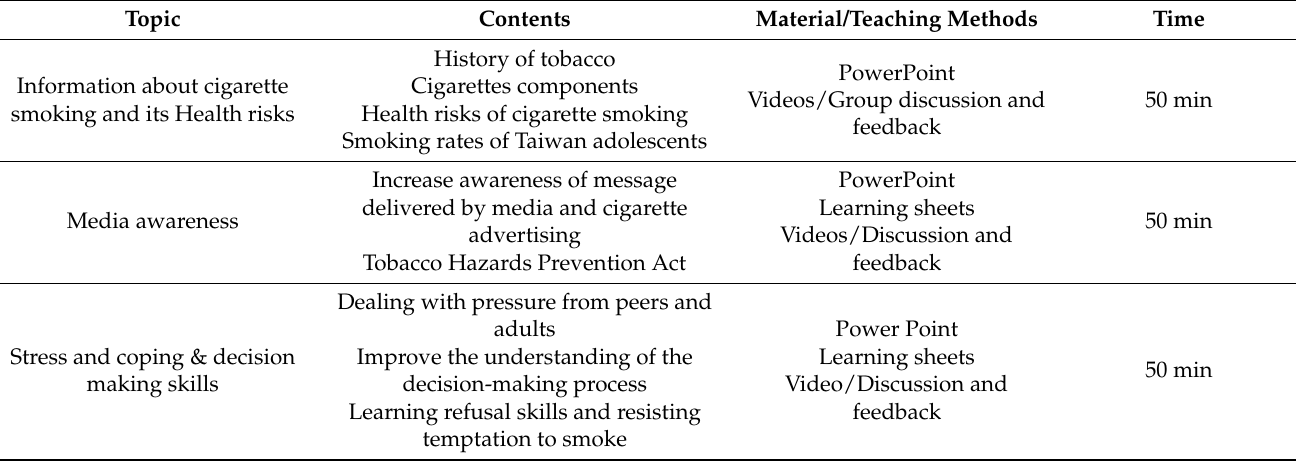
Table 1. The detailed information of smoking prevention